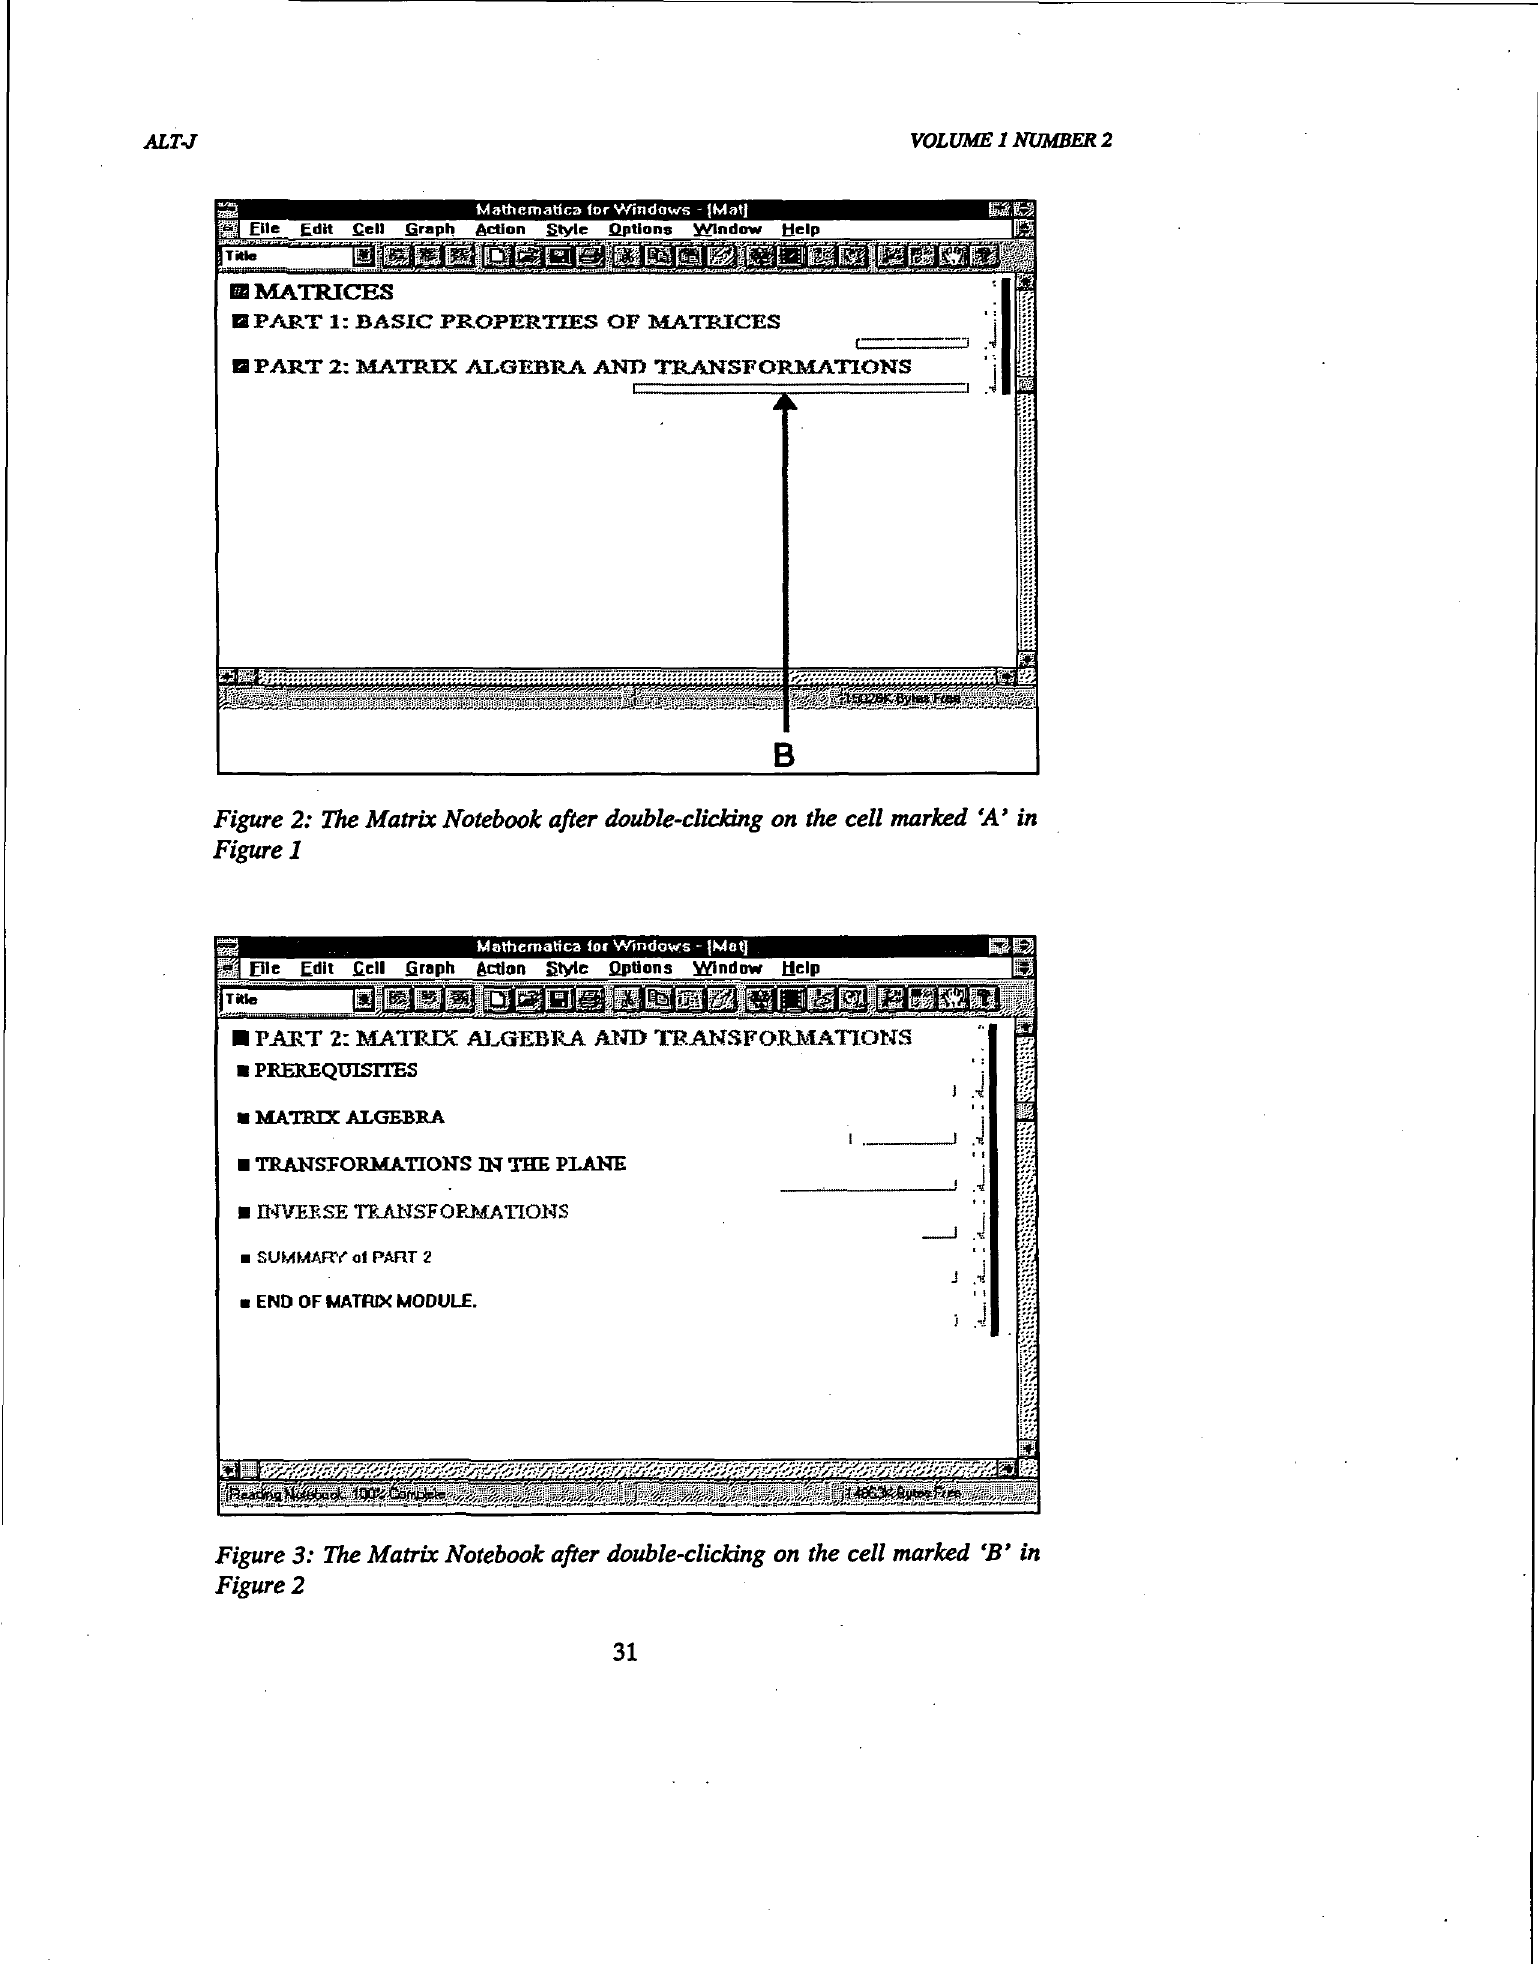
Figure 3: The Matrix Notebook after double-clicking on the cell marked 'B' in Figure